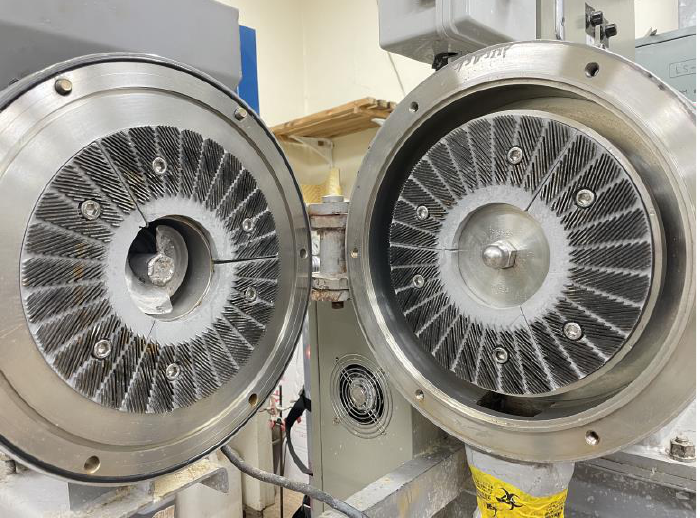
Figure 5. Laboratory single disk refiner fitted with a novel refiner plate without the draft angle.